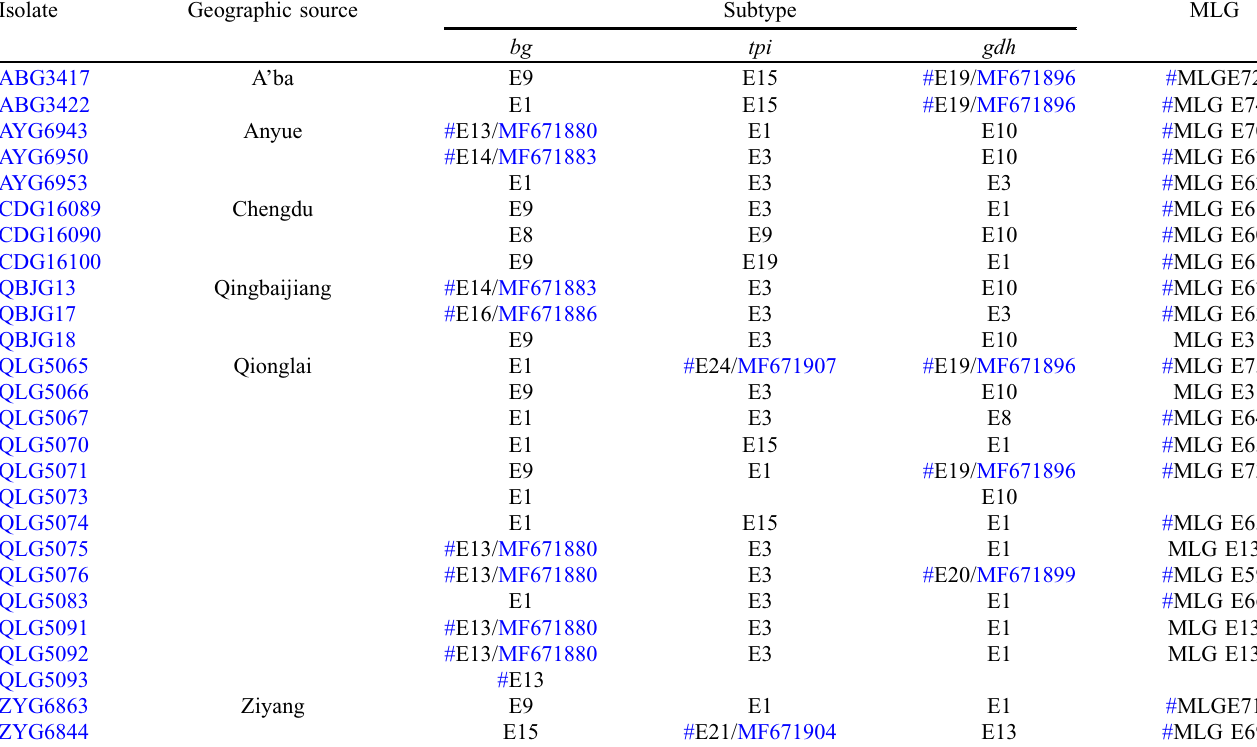
Table 2. Multilocus sequence genotypes of G. duodenalis in pre-weaned dairy calves in Sichuan province. Isolate Geographic